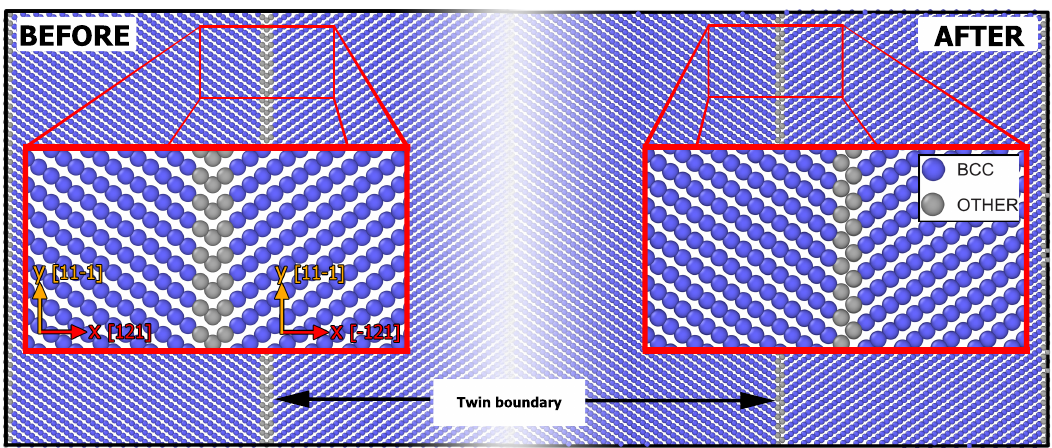
Figure 5. Visualization of the system configuration before and after relaxation on ( ¯101 ) plane of a Σ 3 coherent twin boundary crystal. Atoms are colored according to crystal structure types (blue, bcc; grey, disordered atoms).